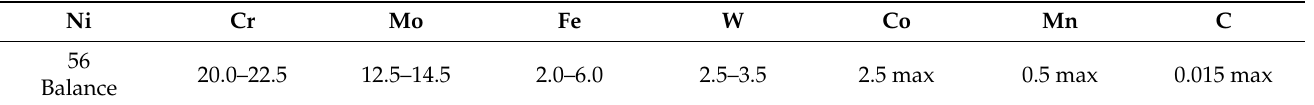
Table 1. Chemical composition of Hastelloy C-22 (mass%) [29].